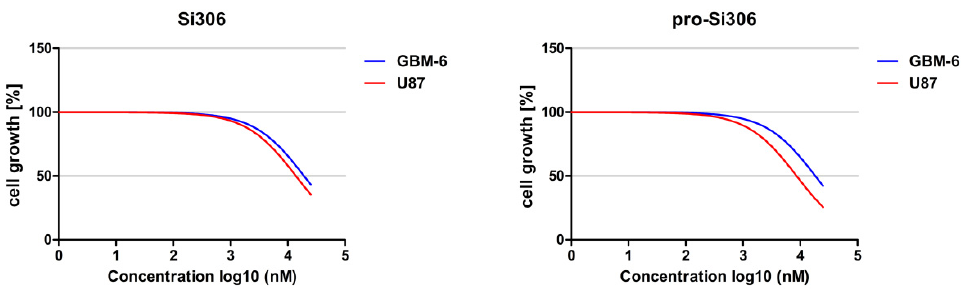
Figure 2. The sensitivity of glioblastoma cells to Si306 and pro-Si306. The effects of Si306 and pro-Si306 on cell growth inhibition were assessed by the MTT assay after 72 h. The graphs represent nonlinear regression fitted curves generated by GraphPad Prism 6.0 software.